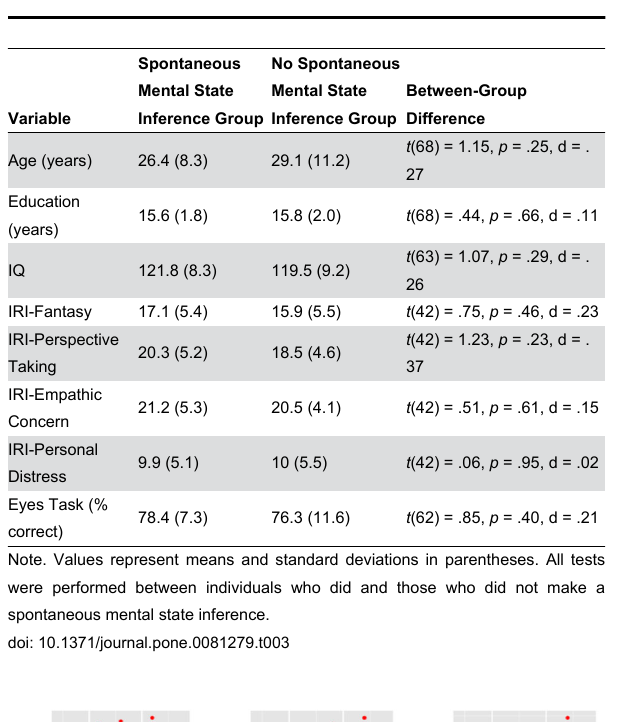
Table 3. Relationship Between Spontaneous Mental State Inference, Demographic Variables, IQ, and Social Variables.